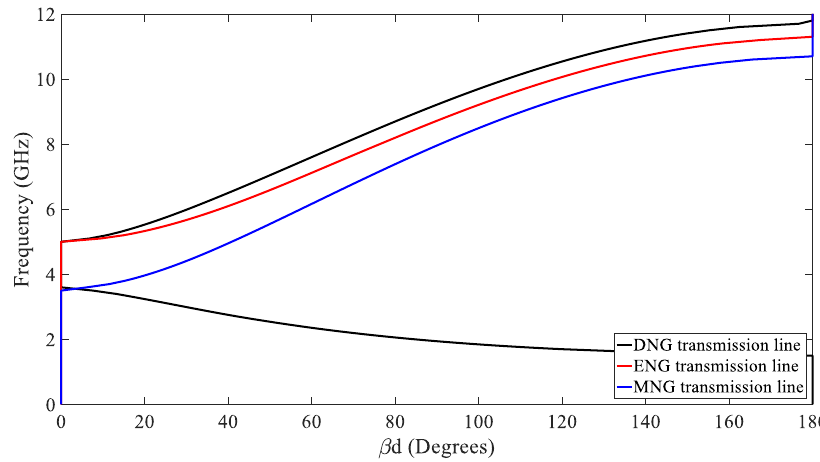
Fig. 2. Dispersion curves of lossless (a) DNG, (b) ENG, and (c) MNG transmission